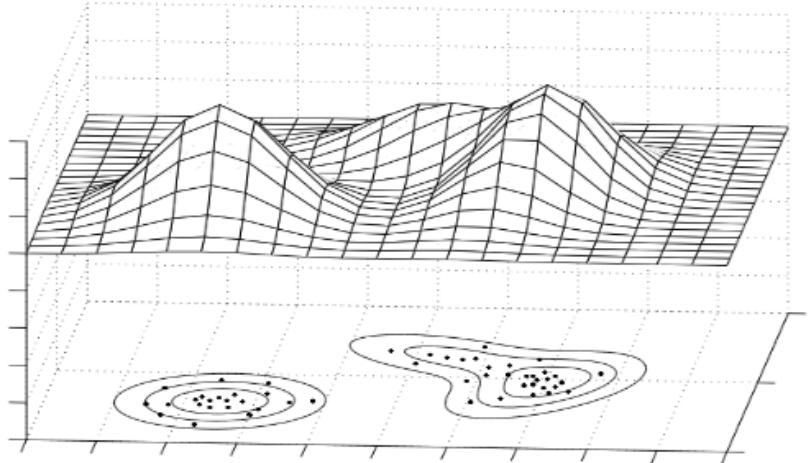
Figure 6. An example of modeling 2-dimensional training dataset by a weighed sum of 3 Gaussian distributions [17]. distributions